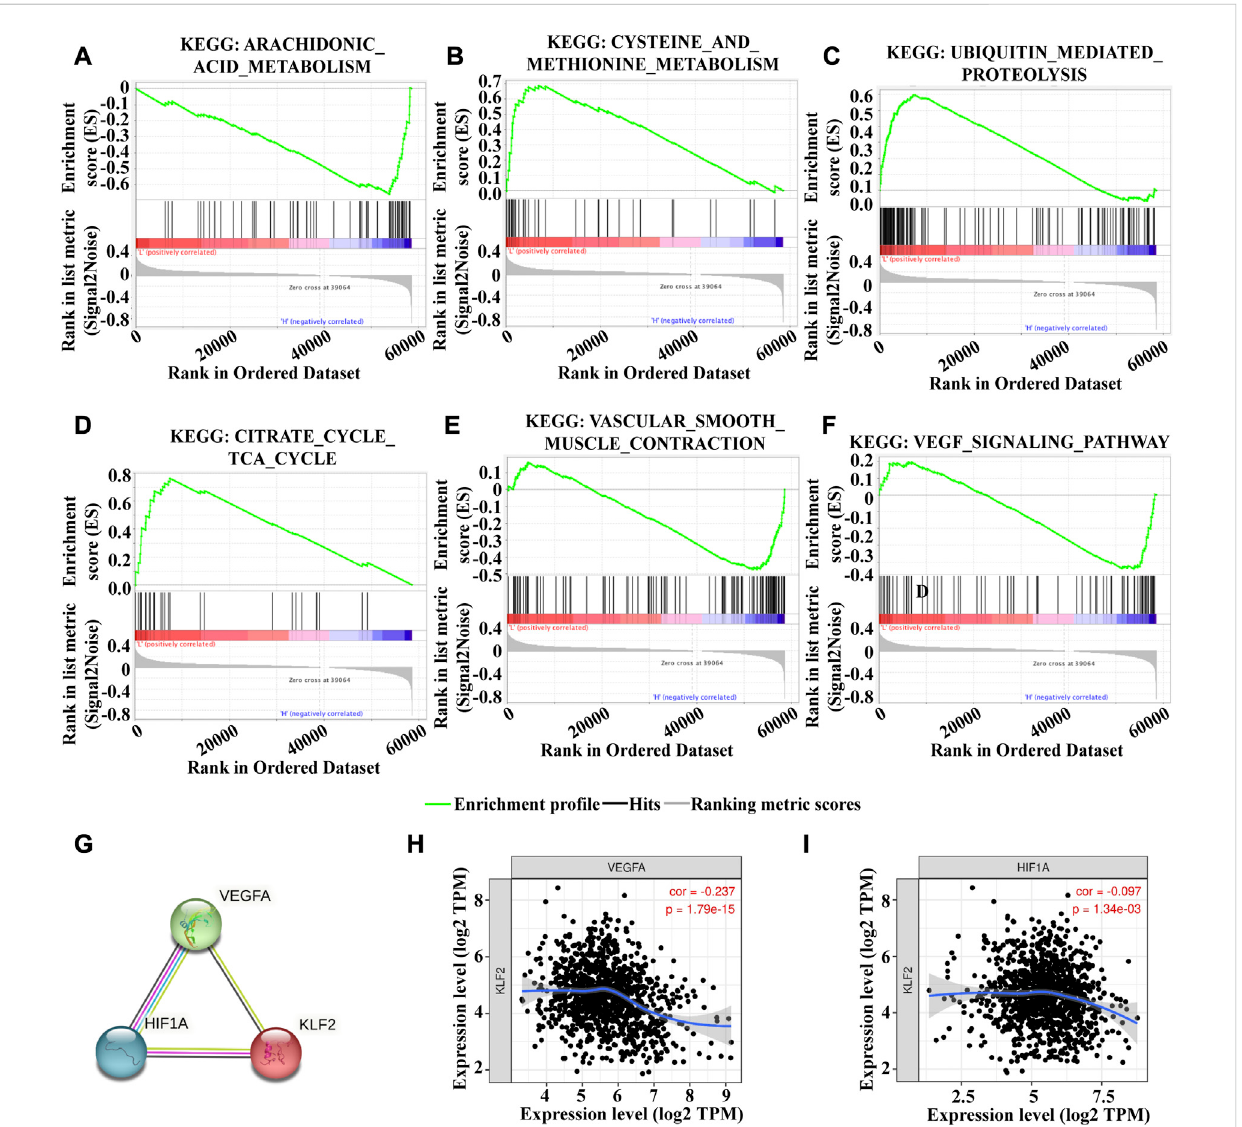
FIGURE 7 Gene set enrichment analysis of KEGG analysis. Arachidonic_acid_metabolism (A) , Cysteine_and_methionine_metabolism (B) , Ubiquitin_ mediated_proteolysis (C) , Citrate_cycle_tca_cycle (D) , Vascular_smooth_muscle_contraction (E) and VEGF_signaling_pathway (F) . (G) . PPI analysis of KLF2, VEGFA and HIf1 α . KLF2 expression correlated with VEGFA (H) and HIf1 α (I) in breast